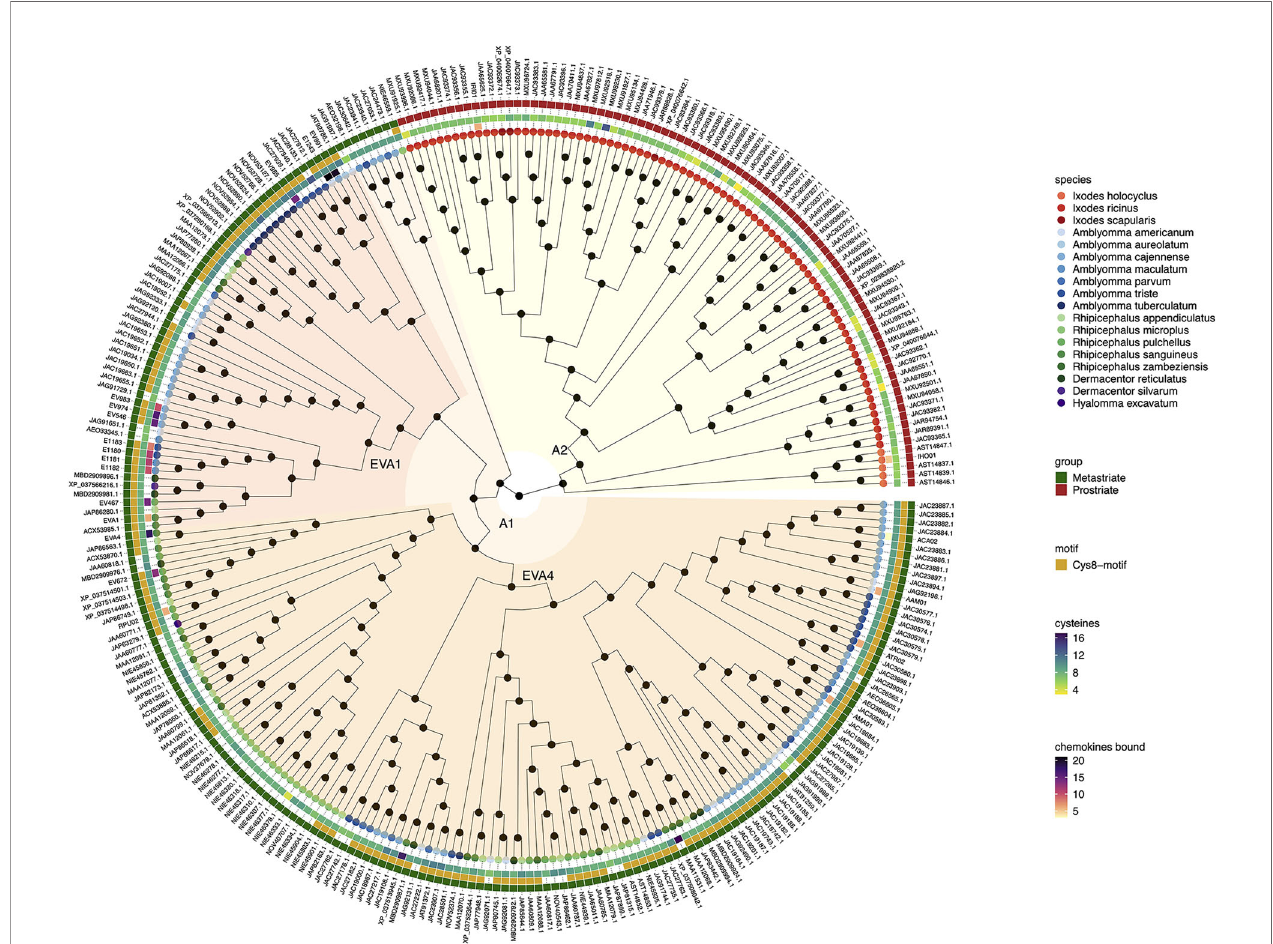
FIGURE 1 | Neighbour-joining tree of class A evasin and evasin-like proteins. Accession numbers of proteins are indicated at the tree tips, which are colour coded by species. The ancestral node at the centre was de fi ned by midpoint rooting. The outermost circle of the heatmap indicates Prostriate or Metastriate lineage. The next two circles of the heatmap indicate the presence of a C-x(14,17) -C-x(3)-C-x(11,16)-C-x(17,20)-C-x(4)-C-x(4,5)-C-x(8)-C (Cys8-motif) and the numbers of cysteines respectively. The innermost circle of the heatmap indicates the number of CC-chemokines bound by biochemically characterized evasins. Classes A1 and A2 were de fi ned as having diverged from the two nodes immediately following the ancestral node and are indicated in orange and yellow respectively. Distinct subclades of class A1 containing EVA1 and EVA4 proteins are indicated in red and dark orange